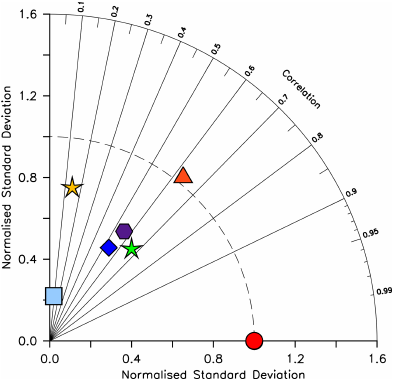
Figure 6. Taylor diagram (Taylor, 2001) of CMIP6 annual av- erage diatom biomass concentrations (in molCm − 3 ) at the year 2014 referenced to KMBM3. The distance to the origin repre- sents the normalized standard deviation. Normalized correlation with KMBM3 is read from the azimuthal position. Perfect agree- ment with KMBM3 is a normalized standard deviation of 1 and a normalized correlation of 1. Normalization against the model, rather than observations, is shown due to the models having greater sim- ilarity with each other than with the very sparse observations of diatom biomass currently available. Models are KMBM3 (red cir- cle), GFDL-ESM4 (green star; Krasting et al., 2018), CanESM5- CanOE (yellow star; Swart et al., 2019), CESM2 (light blue square; Danabasoglu, 2019), CMCC-ESM2 (orange triangle; Lovato et al., 2021), EC-Earth3-CC (blue diamond; EC-Earth Consortium, 2021) and IPSL-CM6A-LR (purple hexagon; Boucher et al., 2018). With the exception of KMBM3, the data for all models were obtained by mining the CMIP6 database (https://esgf-node.llnl.gov/search/ cmip6/, last access: 5 February 2021) using the following search terms: CMIP/phydiat/historical/annual output. Data were accessed between 1–5 February